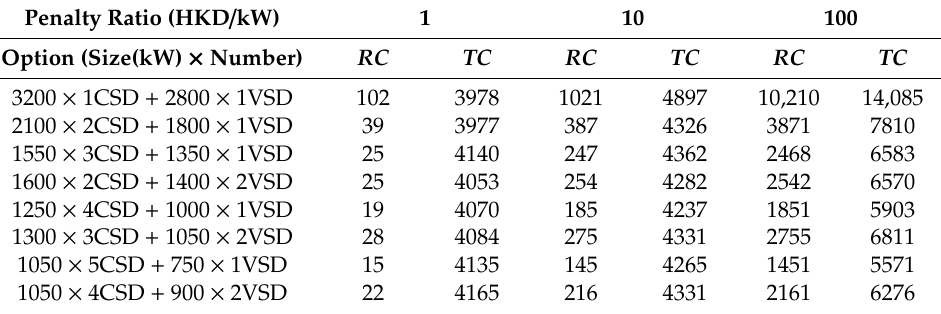
Table 6. Annual availability risk cost (10 3 HKD) and total cost (10 3 HKD) of di ff erent design options.